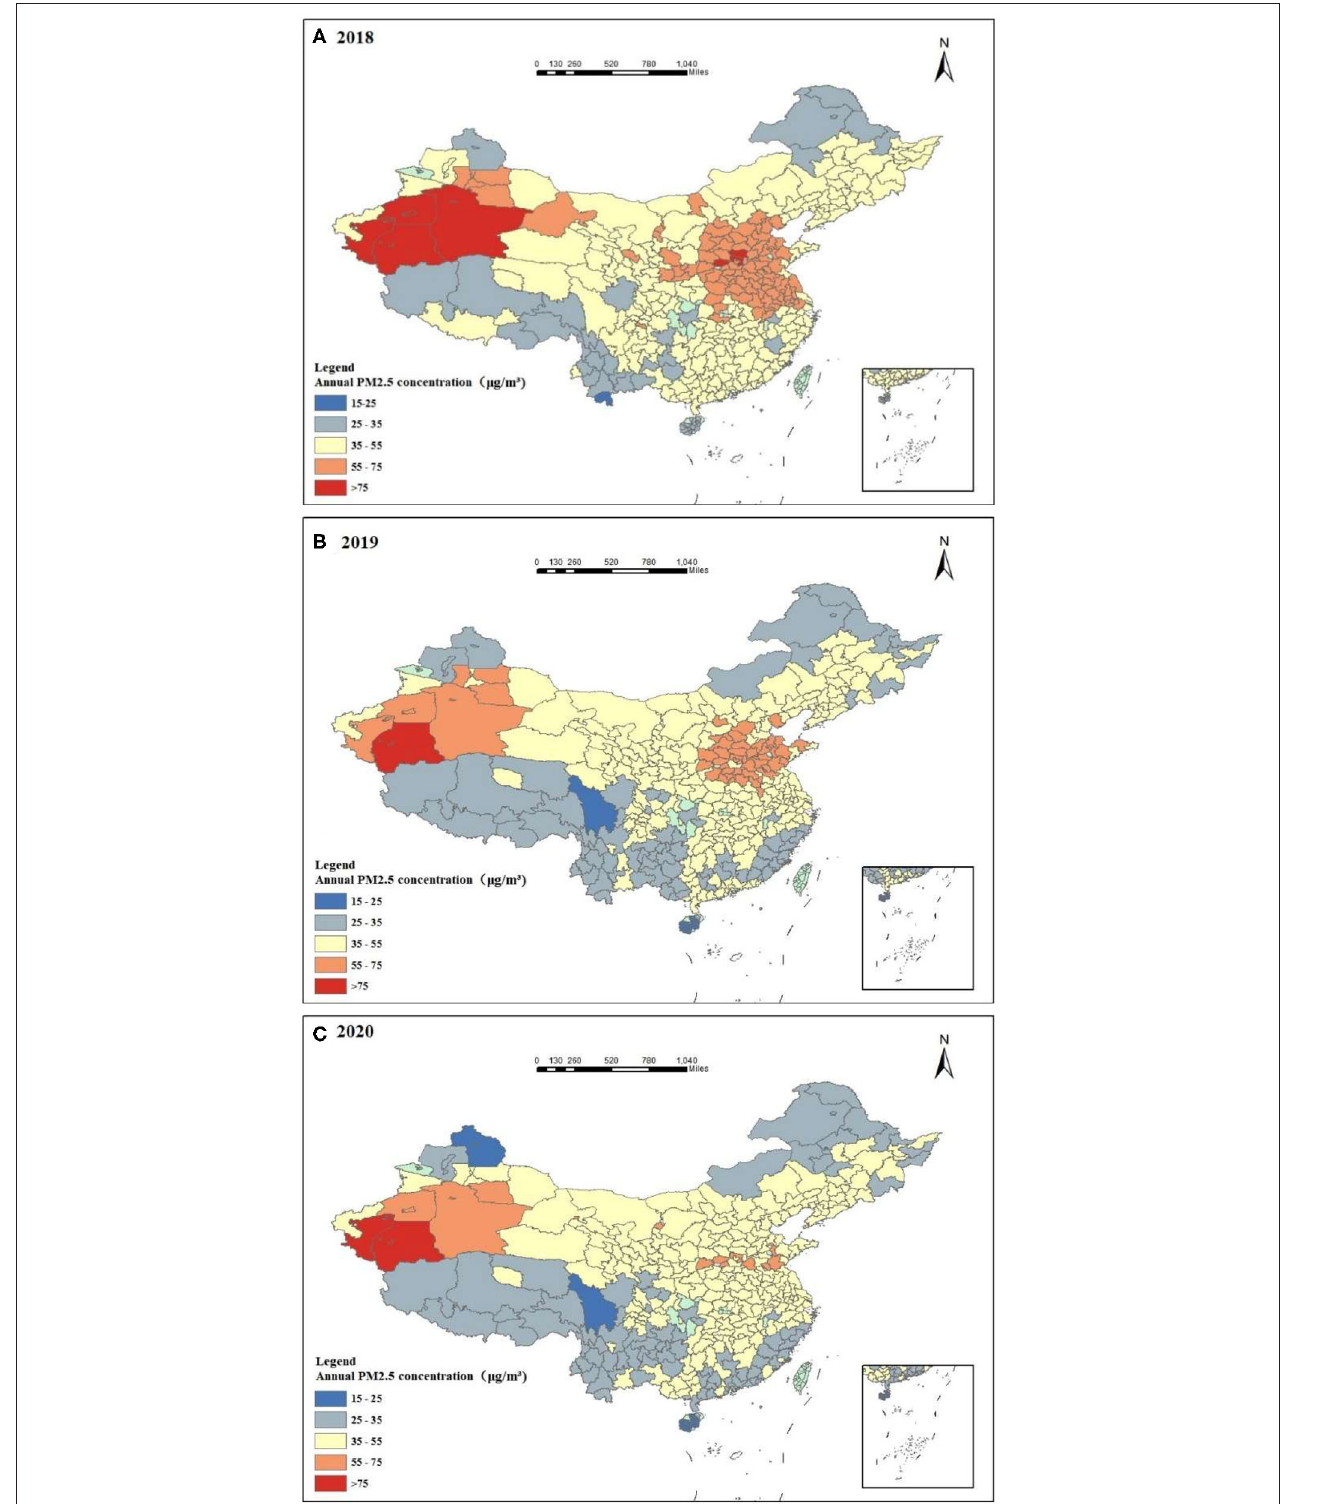
FIGURE 1 | Annual PM2.5 concentration distribution in 2018 (A) , 2019 (B) , and 2020 (C) .